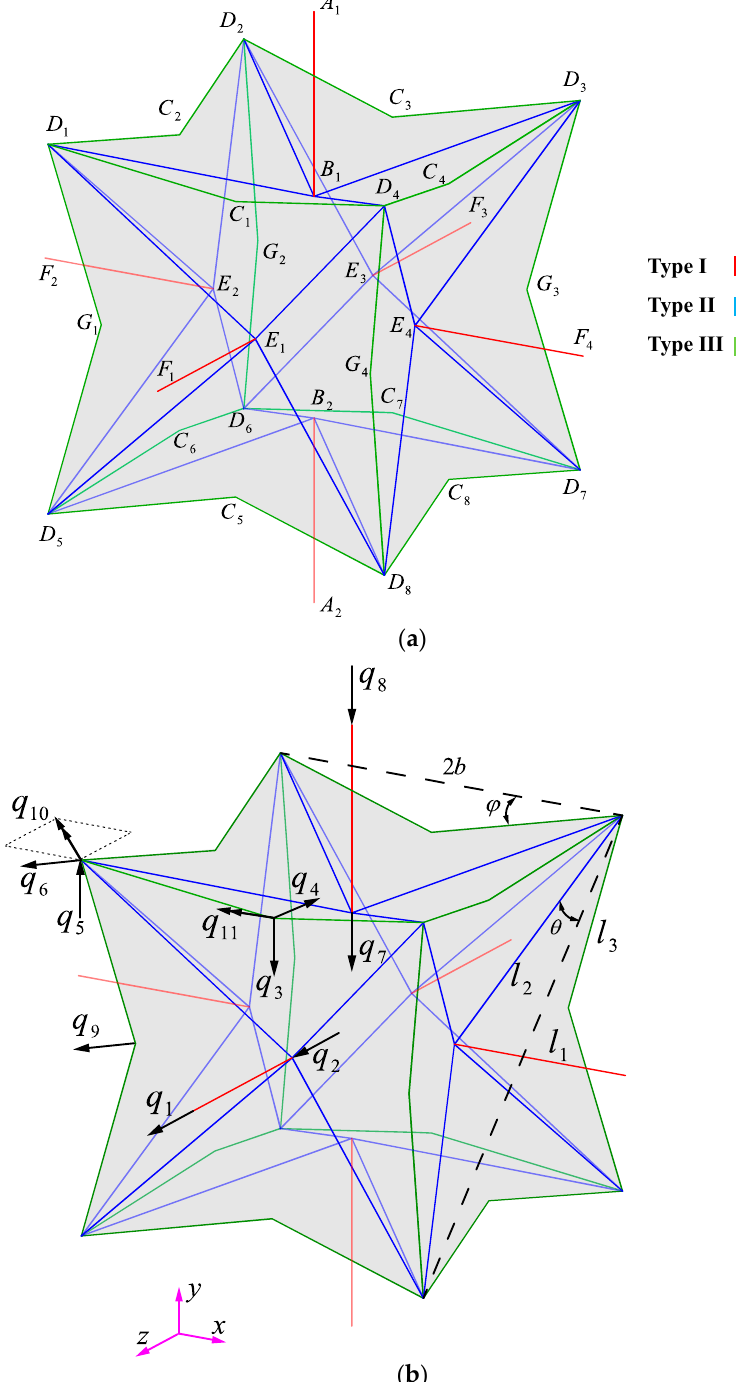
Figure 2. ( a ) An idealized 3D re-entrant unit cell and its strut types, ( b ) degrees of freedom (DOFs) of the unit cell. The double arrows represent the rotational degrees of freedom. More illustrations of the unit cell, its dimensions, and boundary conditions can be found in Figures